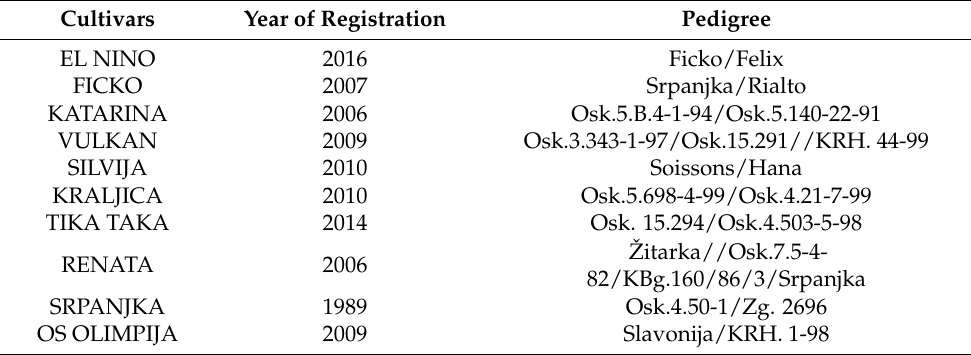
Table 1. The list of cultivars, their year of registration, and